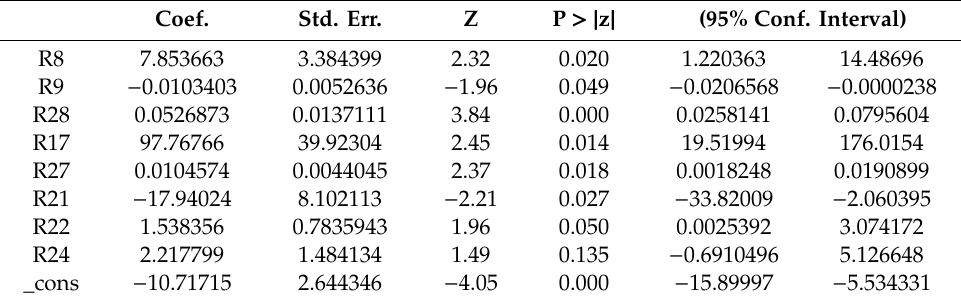
Table 6. Regression results three years before failure.